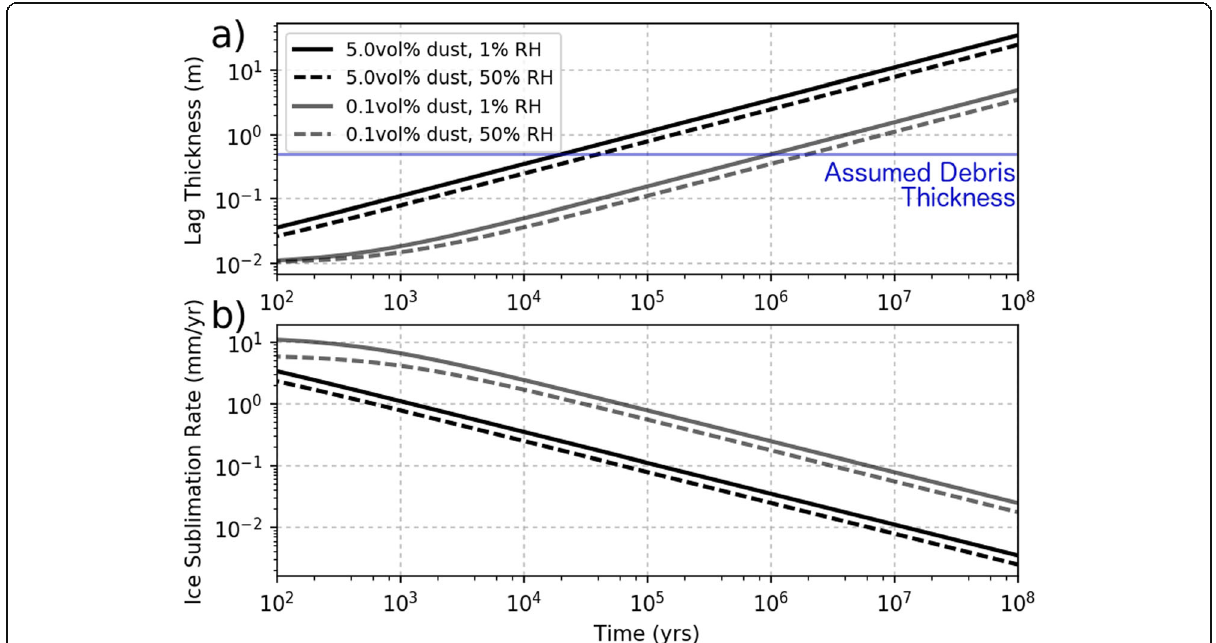
Fig. 7 Time-evolution of lag thickness and ice sublimation rate of a Martian dirty ice deposit. a Modeled increase in lag thickness over time for different atmospheric humidities (solid vs. dashed lines) and ice deposit dust concentrations (black vs. gray lines) assuming an ice surface temperature of 210 K. The minor ticks on the x-axis give even increments from the base. The lag thickness in a is given by the buried ice sublimation rate calculated from Eq. 5 ( b ) integrated over time and multiplied by the dust concentration. This calculation assumed an initial debris thickness of 1 cm. The blue line in a gives the assumed debris thickness used to calculate the ablation rate in the